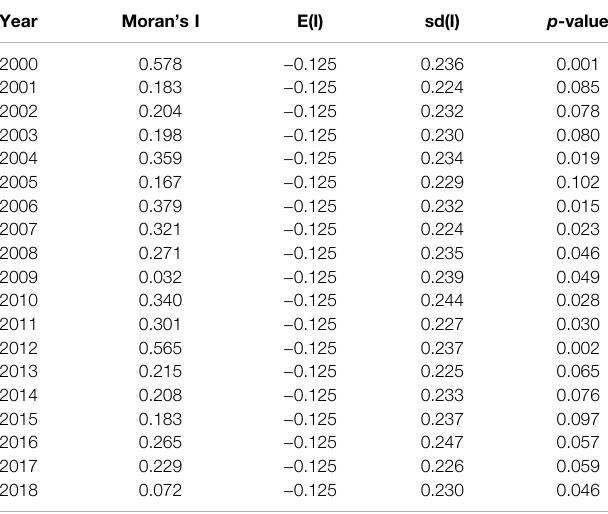
TABLE 2 | Moran ’ s Ⅰ index of PM